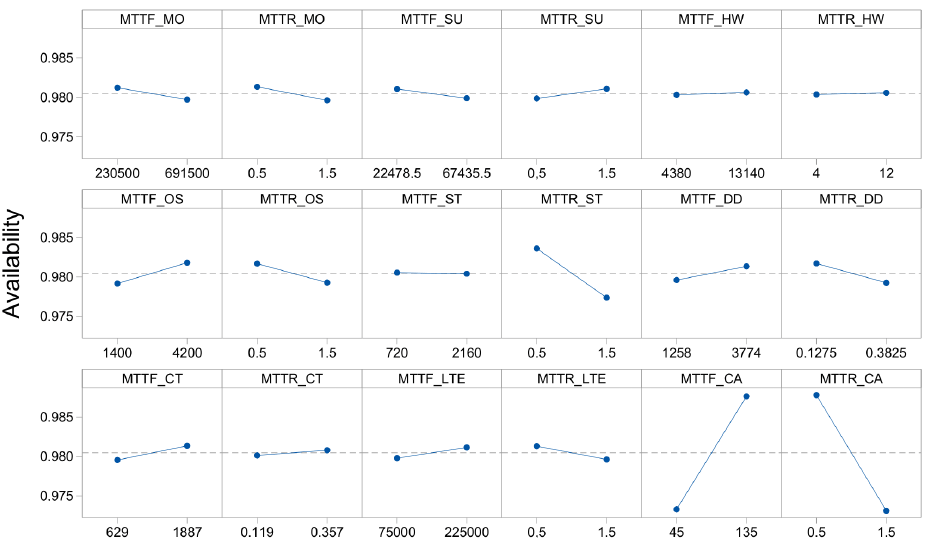
Figure 7. Main effects for